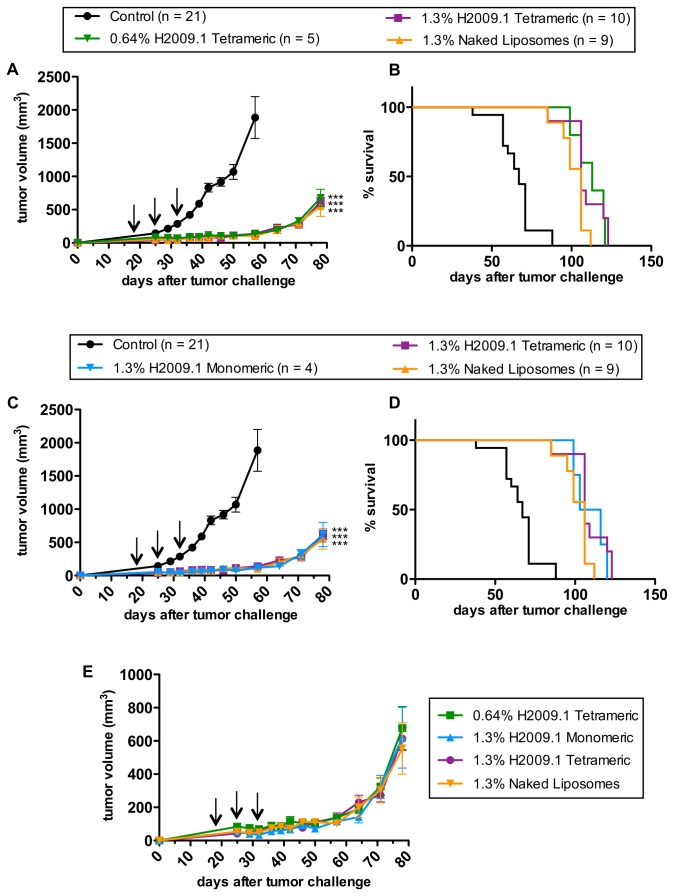
Liposomal H2009.1 peptide affinity and density do not alter in vivo efficacy.Subcutaneous H2009 tumors were established in the flank of NOD/SCID mice. Tumor-bearing mice were treated with HBS (control) and 4mg/kg of different liposome formulations, based on the total concentration of doxorubicin. (A) Tumor growth curves and (B) Kaplan-Meier survival curves for mice treated with 0.64% H2009.1 tetrameric, 1.3% H2009.1 tetrameric, or 1.3% naked liposomes demonstrate that changes in liposomal peptide concentration do not alter tumor growth inhibition or survival; all 3 liposome formulations inhibit tumor growth to the same extent and increase survival compared to control mice to the same extent (p < 0.0001). (C) Tumor growth curves and (B) Kaplan-Meier survival curves for mice treated with 1.3% H2009.1 monomeric, 1.3% H2009.1 tetrameric, or 1.3% naked liposomes demonstrate that changing the affinityof the peptides displayed on liposomes does not alter tumor growth inhibition or survival; all 3 liposome formulations inhibit tumor growth to the same extent and increase survival compared to control mice to the same extent (p < 0.0001). (E) Graphing the tumor growth curves for the 3 different H2009.1 liposome formulations and the naked liposomes on the same axis without the control group allows for a clearer visualization of the overlapping nature of the 4 different liposome curves and demonstrates that liposomal H2009.1 peptide concentration and affinity and even the presence of the H2009.1 peptide, do not affect liposomal tumor inhibition. Arrows indicate treatment days. *** p < 0.001verses control.